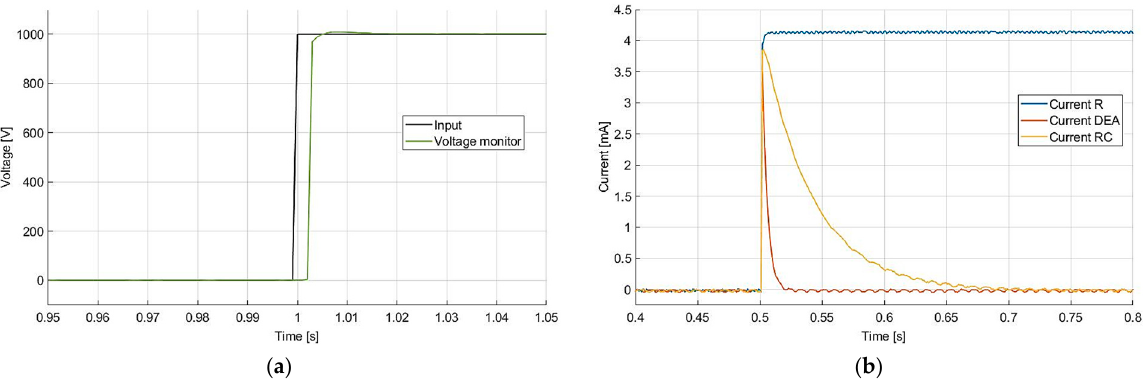
Figure 8. High voltage amplifier feedback ( a ) voltage monitor at a voltage step ( b ) current monitor at different loads.